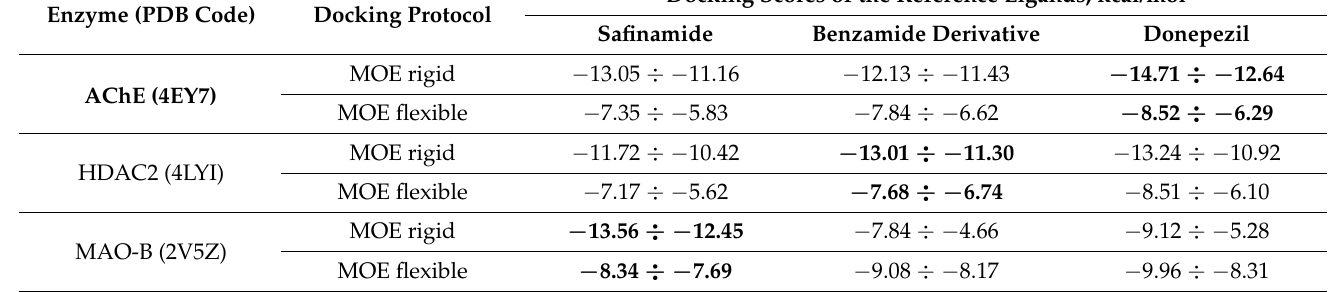
Table 1. Re-docking (in bold) and cross-docking scores of the co-crystallized ligands in the three enzymes using two docking protocols in MOE; the ranges span the scores of the best 10 poses. The lowest RMSD values (root mean square deviations; MOE rigid/flexible docking protocol) for the re-docked ligands (in bold) are the following: AChE—1.19 Å/0.93 Å; HDAC2—1.29 Å/0.66 Å; MAO-B—1.71 Å/0.78 Å.